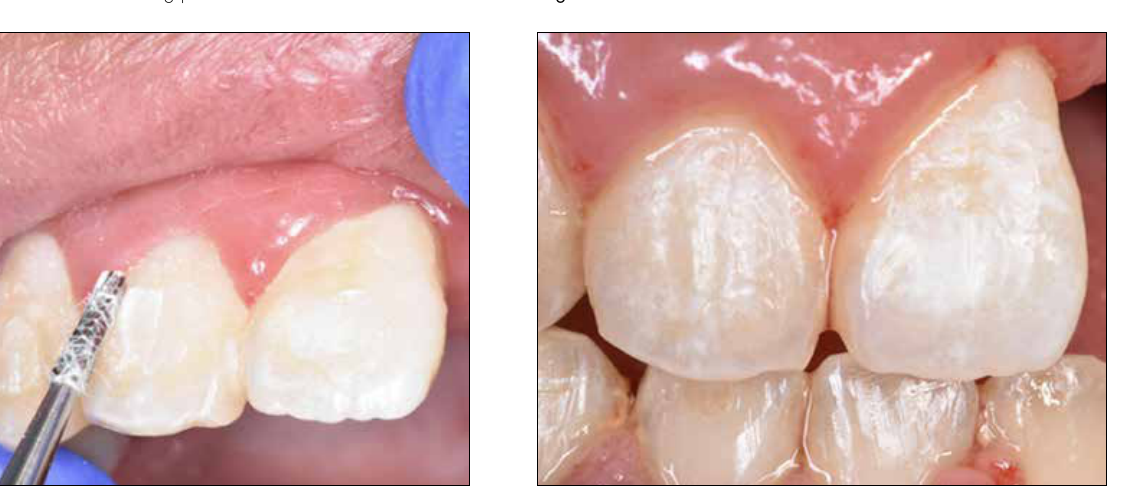
Figure 5. Debond with debonding pliers. Figure 6. The bulk of adhesive remains on the enamel surface.